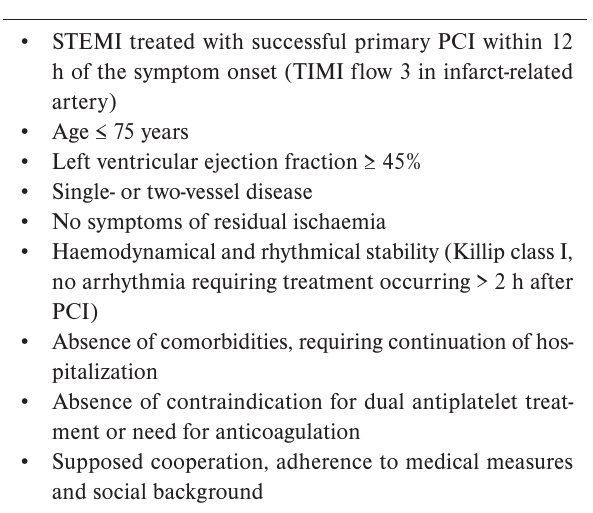
Table 1. Inclusion